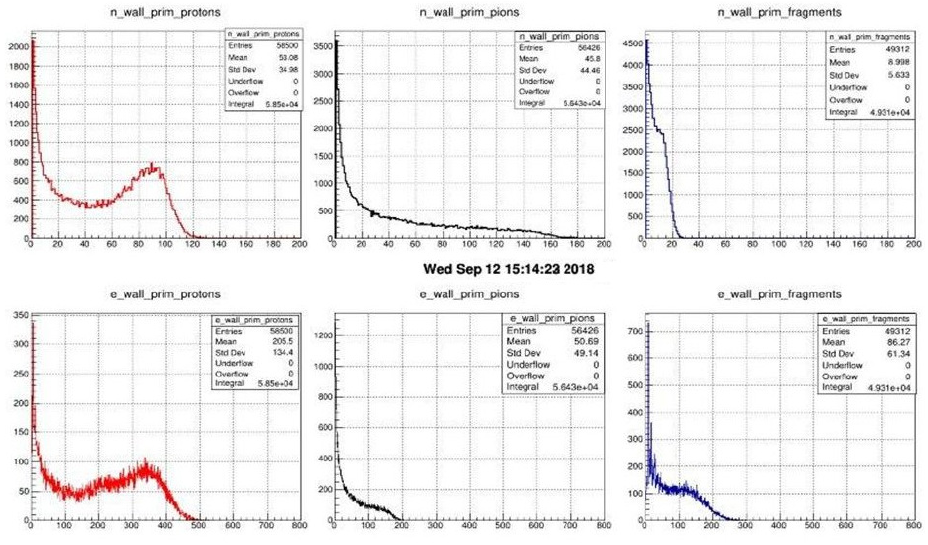
Figure 4. Multiplicity distributions for protons, pions and fragments for 5.5 A GeV beam of Au ( upper part ) and total energy distribution in GeV (lower